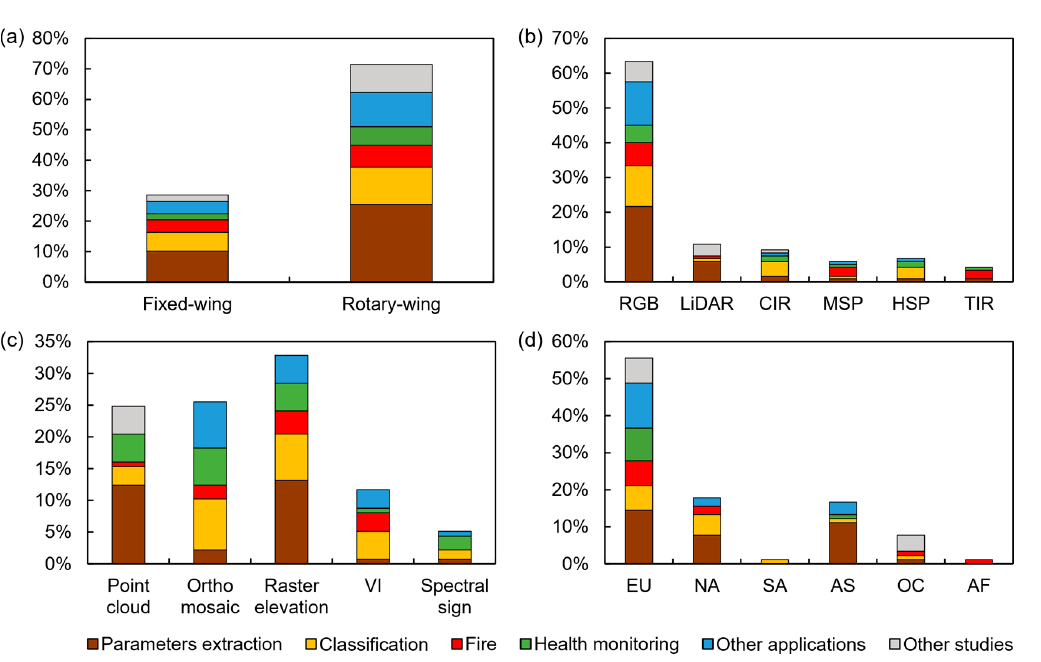
Figure 3. Distribution of the reviewed studies per: ( a ) unmanned aerial vehicle type; ( b ) sensing payload type (CIR: colour infrared; MSP: multispectral; HSP: hyperspectral; TIR: thermal infrared); ( c ) most relevant outcomes used; ( d ) and continents were the studies were performed (EU: Europe; NA: North America; SA: South America; AS: Asia; OC: Oceania; AF: